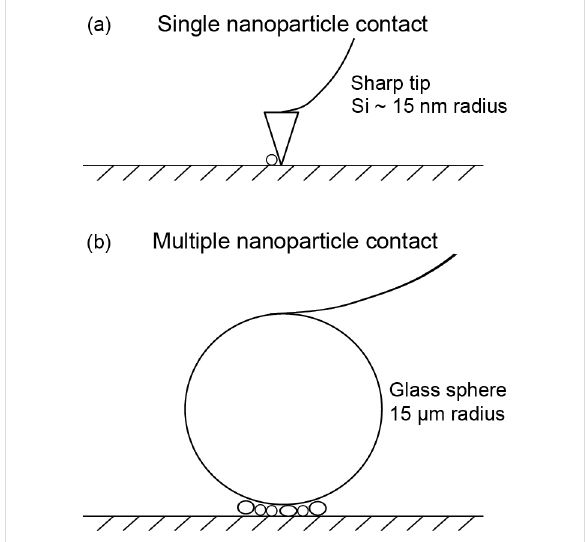
Figure 2: Schematics of (a) a sharp tip pushing a particle in single- particle contact and (b) a glass sphere sliding over several particles in multiple-particle